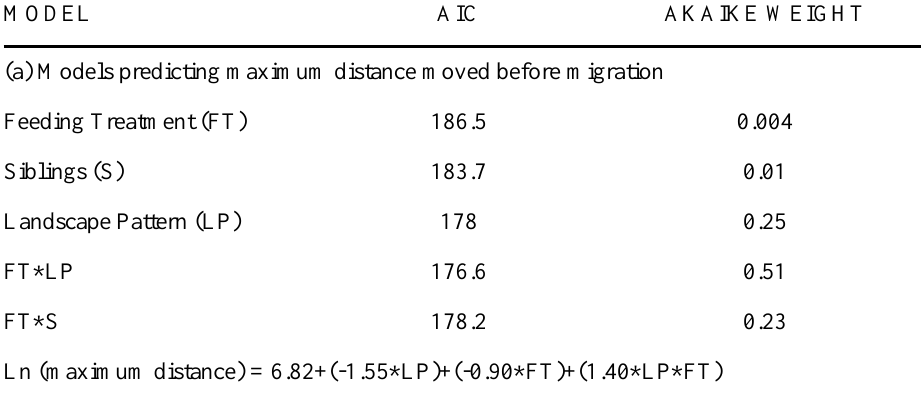
1727.9 0.05 1722.6 0.7 1726.3 0.11 1725.9